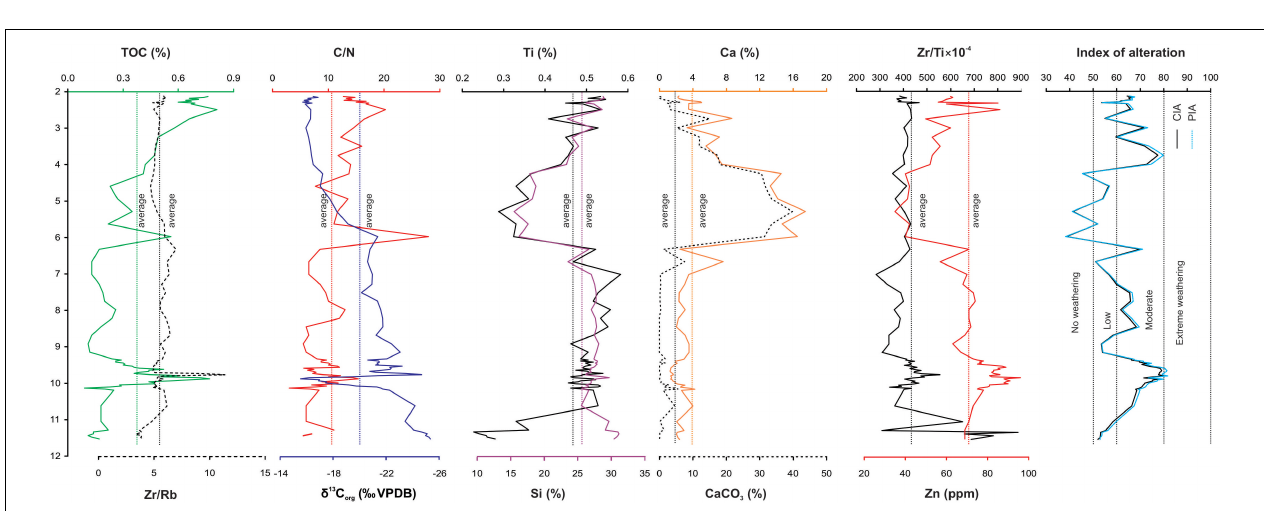
FIGURE 5 | Comparison of the proxy records of source of organic matter and sediment–water interaction at Lake Coatetelco with the oxygen isotope composition based paleo-precipitation registers from Juxtlahuaca Cave and Cueva del Diablo (Bernal et al., 2011; Lachniet et al., 2013) in southwest Mexico, Ti-based runoff record from the Etzatlán-Magdalena Basin (Vázquez-Castro et al., 2017) and vegetation compositions of Lake Zirahuén (Lozano-García et al., 2013) in western Mexico, and authigenic carbonate abundance (TIC) in Lake Chalco of the Basin of Mexico (Lozano-García et al., 2015).